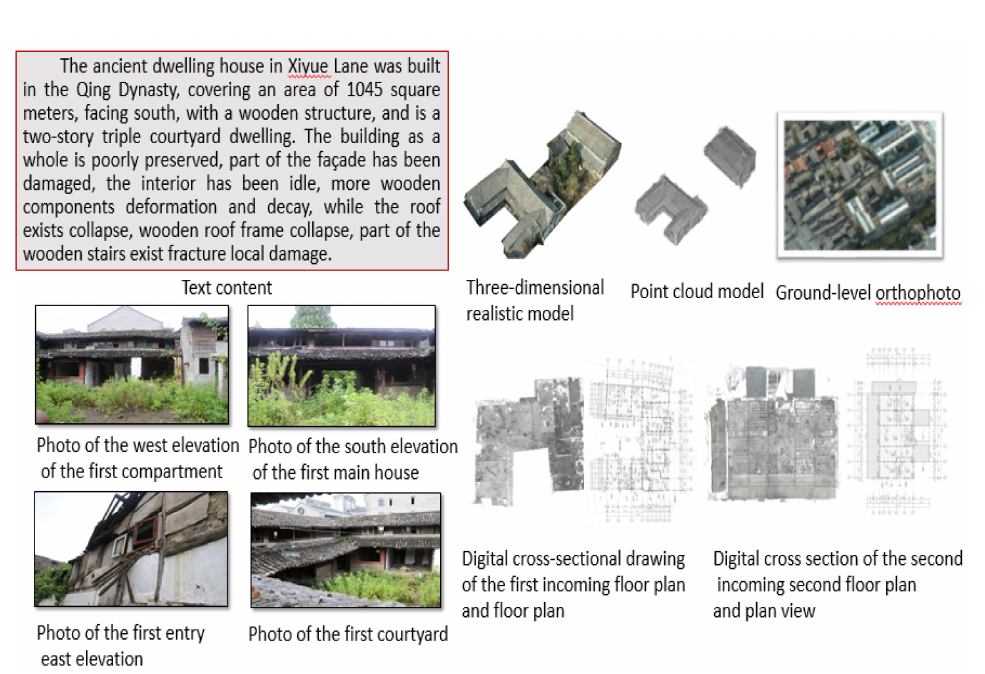
Fig. 2 Content of descriptive files.